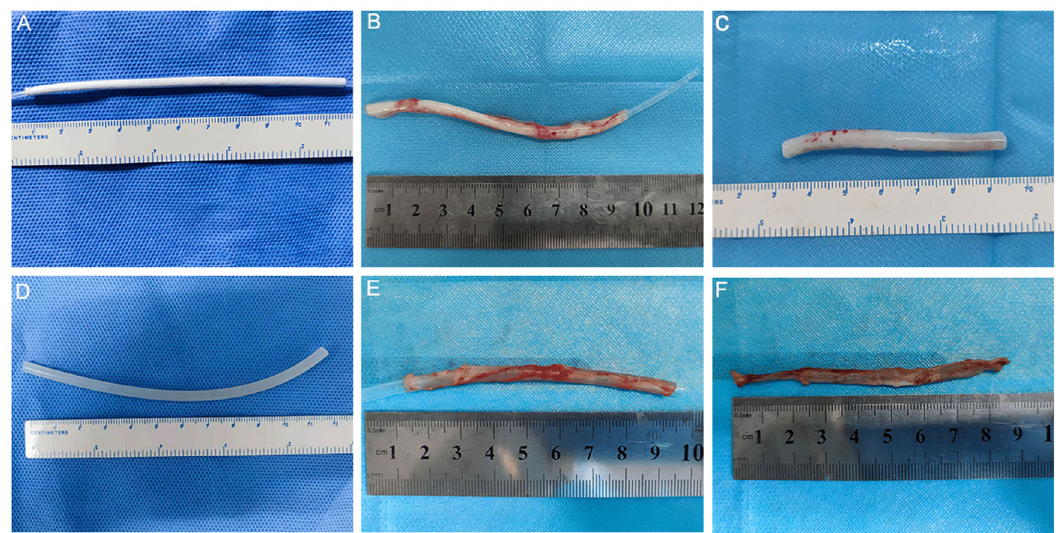
Fig. 3 The vascular scaffold(PLCL/PU)/silicone tube(shell/core) before the embedding ( A ). After 4 weeks of embedding in the abdominal area of the rabbit ( B ). The biotube after removing the silicone tube and excess connective tissue ( C ). The silicone tube